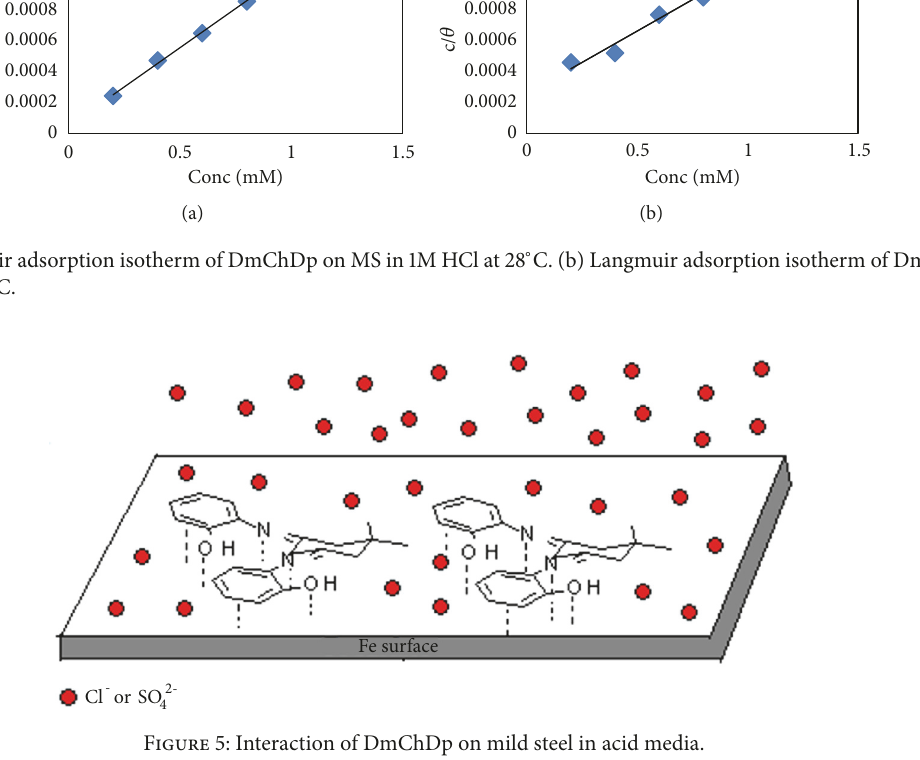
Figure 5: Interaction of DmChDp on mild steel in acid